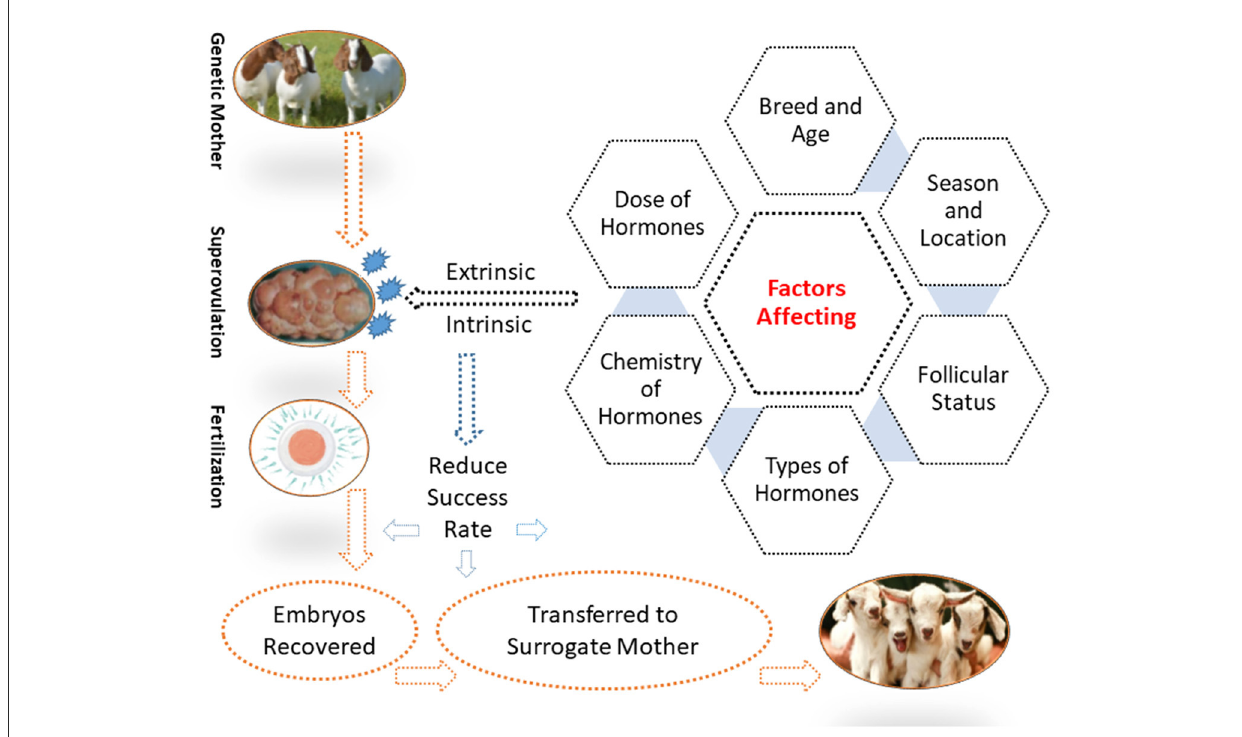
FIGURE1 Factors affecting the superovulatory response in goats.